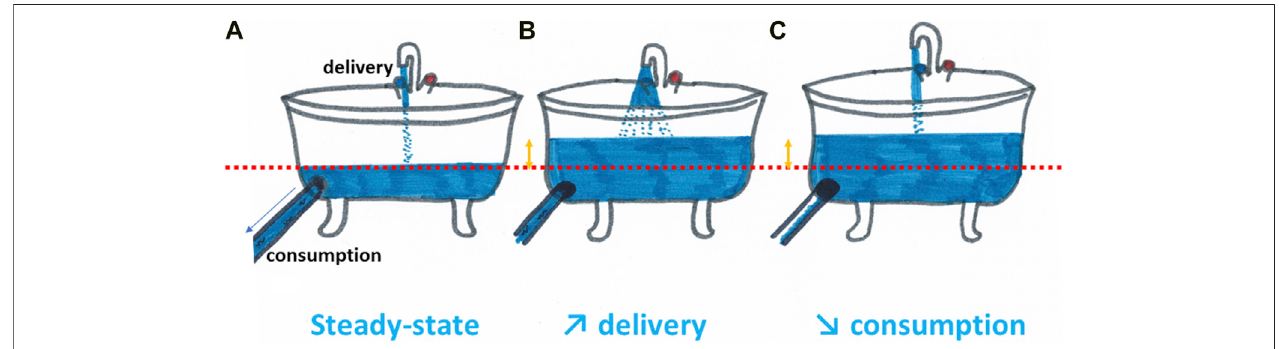
FIGURE4| Increasingtumor oxygenationcanbe compared withthe fi llingofabath. Torisethe waterlevel inabathtub compared tothesteady state (A) ,youmay either increase the water supply by playing with the faucet (B) or decrease the opening of the draining plug (C) . In a similar manner, pharmacological strategies aimed at increasing the tumor oxygenation are targeting either the oxygen delivery (through an increase in perfusion, a decrease in blood viscosity or a better release of oxygen from hemoglobin) or the oxygen consumption (through the decrease of metabolic activity of the tumor cells).